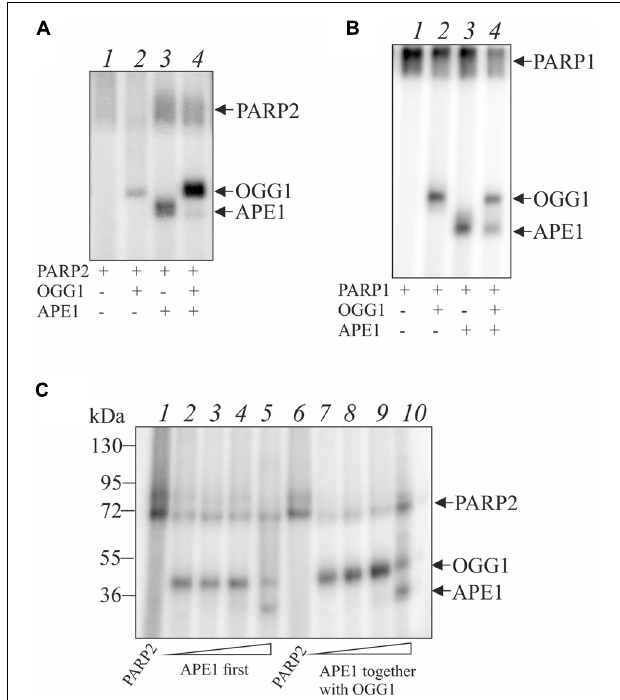
FIGURE 4 | Poly(ADP-ribosyl)ation of OGG1 catalyzed by PARP1 or PARP2 in the presence of AP site-containing DNA. The reaction mixtures